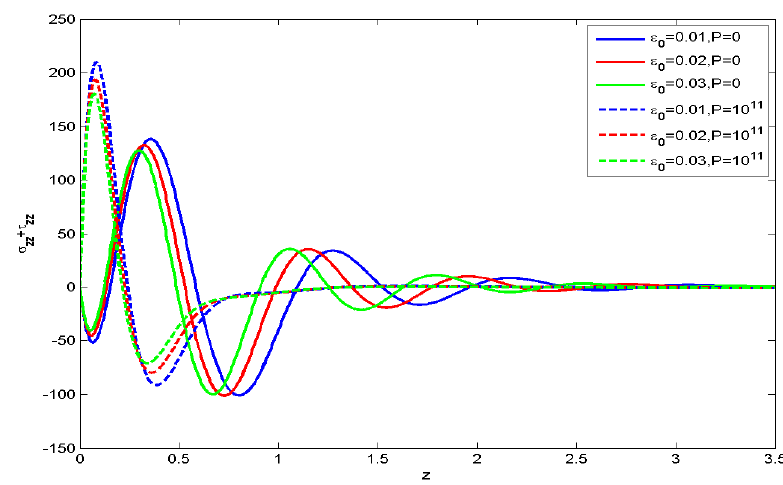
τ concerning z with electric field 0